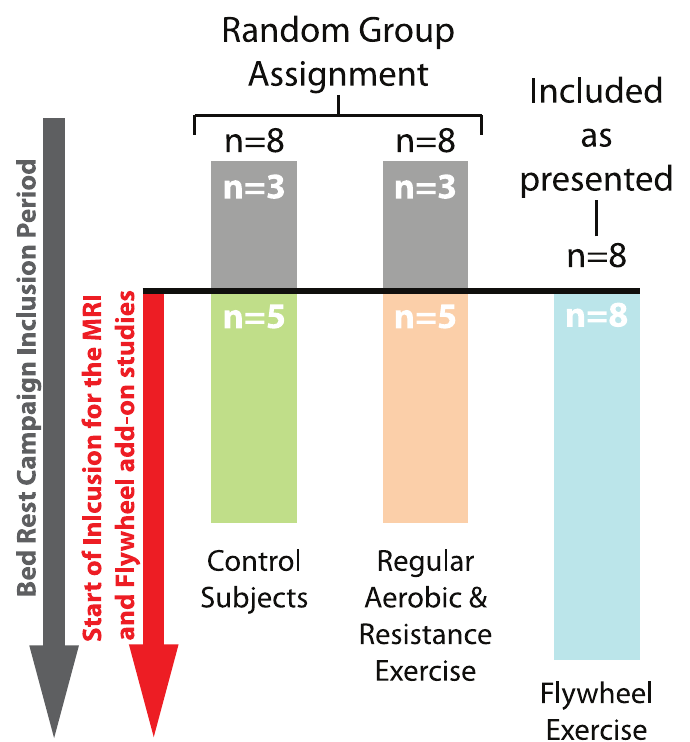
Fig 1. Subject inclusion flowchart. In total, 18 subjects participated in this study. These subjects were divided over 3 groups. Ten subjects were participants of the parent HDBR study and had been randomly assigned to either a HDBR control group or a HDBR regular aerobic and resistance exercise group. The remaining 8 subjects were sampled from an add-on study to the parent HDBR study. These 8 subjects completed flywheel exercise during the 70 days of HDBR and were included in the order they signed